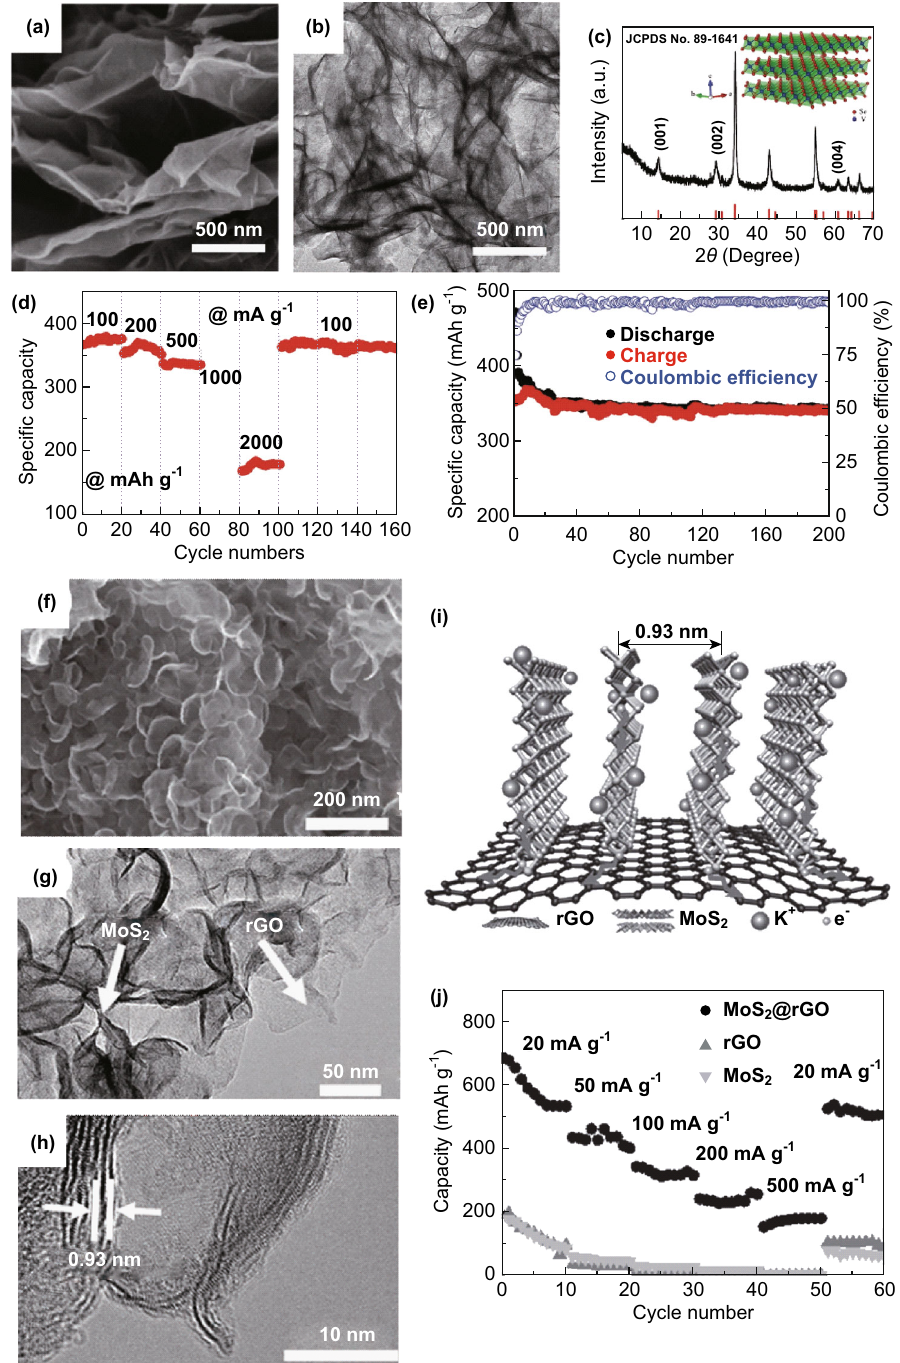
Fig. 17 2D nanoflake ensemble-based materials for KIBs. a SEM, b TEM, and c XRD pattern of ultrathin layered VSe 2 nanoflakes. d Rate capabilities of VSe 2 nanoflakes. e Cycling stability and Coulombic efficiency of VSe 2 nanoflake electrode at 0.2 A g - 1 . Reproduced with permission [149]. Copyright (cid:2) 2018, John Wiley & Sons, Inc. f SEM, g TEM, and h HRTEM images of MoS 2 @rGO composite. i Schematic illustration showing paths for K-ion diffusion and electron conduction in MoS 2 @rGO composites. j Rate performance of MoS 2 @rGO, MoS 2 particle, and pure rGO. Reproduced with permission [150]. Copyright (cid:2) 2017, John Wiley & Sons,